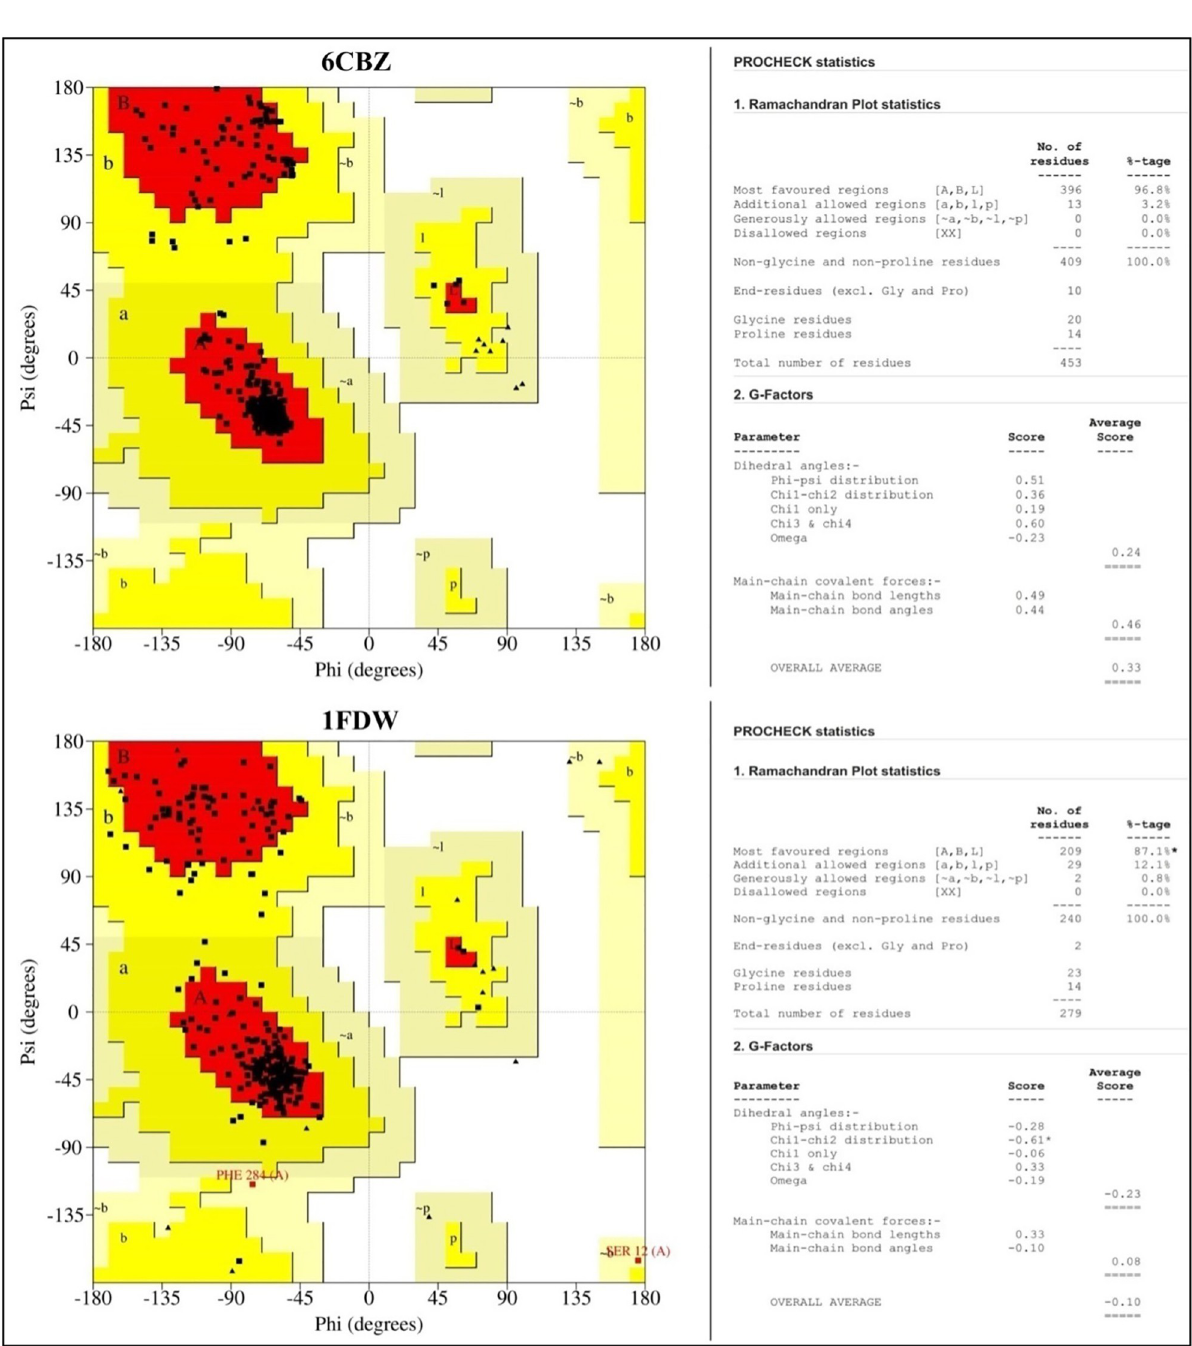
Fig 1. Ramachandran plot for the model of the structure of ER α (PDB: 6CBZ) and human 17 β -HSD1 (PDB: 1FDW) proteins generated by PROCHECK. The red color region denotes residues of the protein in the most favored regions; the brown color denotes residues in the additional allowed regions and the yellow indicates residues in the generously allowed